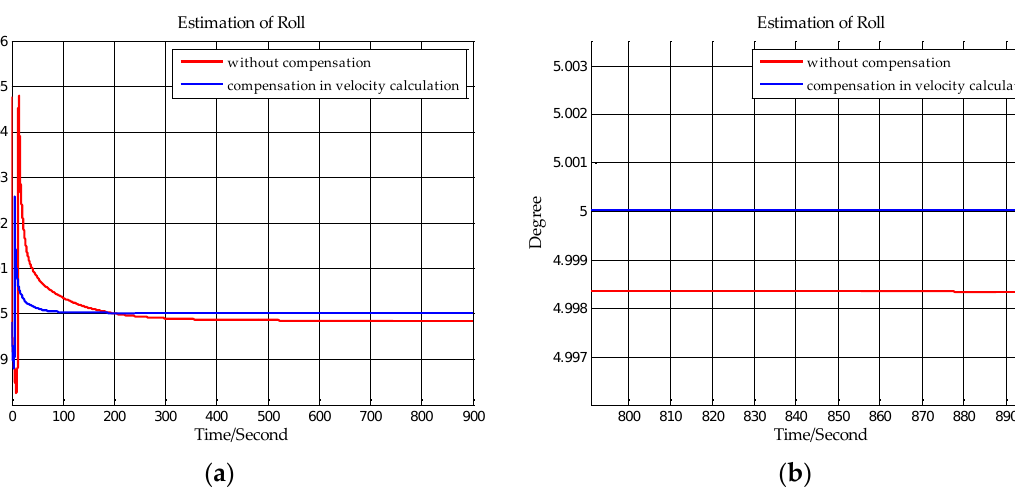
( b ) Figure 8. ( a ) is the estimation of pitch with compensation in velocity calculation, and ( b ) is the enlarged view of ( a ) in the last 100 s. ( a ) ( b ) Figure 9. ( a ) is the estimation of yaw with compensation in velocity calculation, and ( b ) is the enlarged view of ( a ) in the last 100 s.